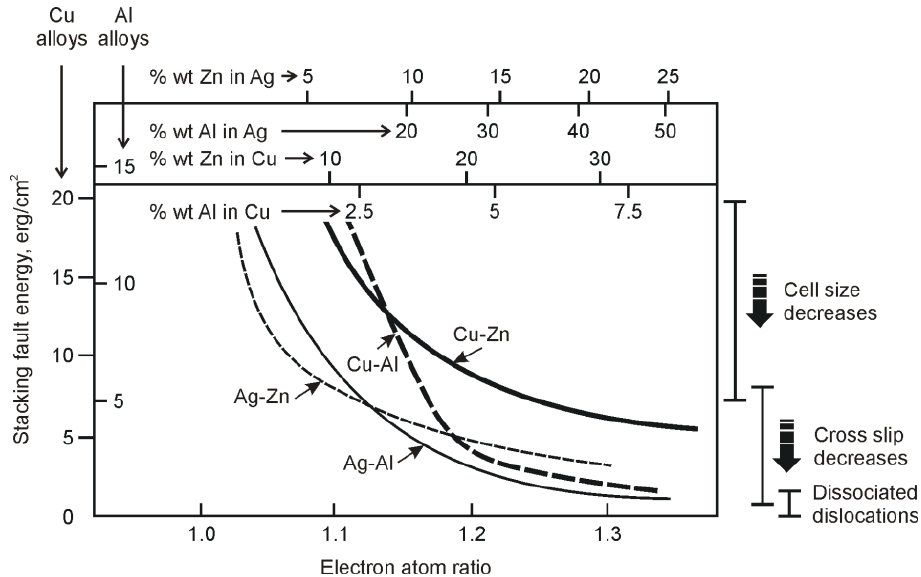
Figure 11. Dependence of dislocation cell size and tendency for cross-slip and dissociation of dislocations on stacking fault energy in copper and silver alloys. Based on Swann 1963.